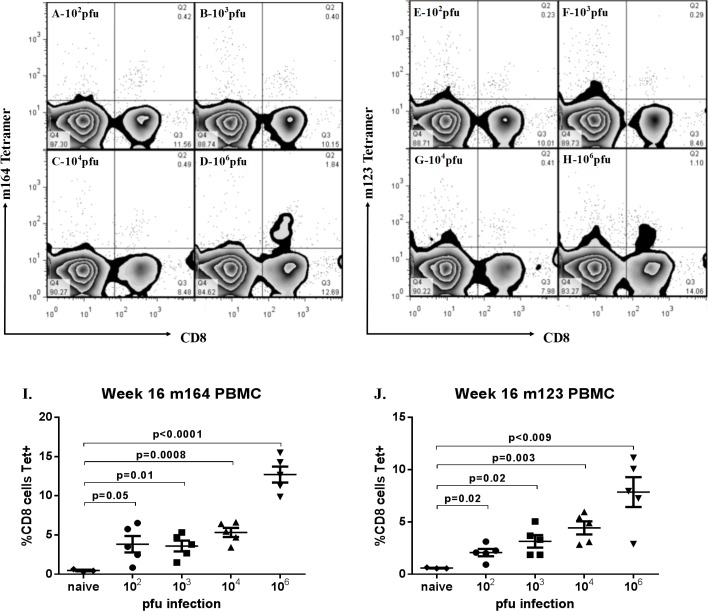
Murine Cytomegalovirus (mCMV) specific T-cell inflation depends upon infecting dose.Mice 8–10 weeks old infected intraperitoneally with 102 (A&E), 103 (B&F), 104 (C&G), or 106 (D&H) plaque forming units (pfu) Smith strain mCMV had peripheral blood mononuclear cells (PBMC) evaluated 16 weeks after infection for inflationary mCMV-specific T-cells. PBMC incubated with tetramers specific for m164 (A-D) or m123 (E-H) epitopes and CD8 were evaluated by flow cytometry and representative scatter plots from individual mice are shown. Mice infected with 106 pfu mCMV show classic inflation of m164 and m123-specific CD8+ cells as previously described by others (D&H). In contrast, mice infected with lower titers show less inflation by 16 weeks (m164 A-C, pp89 E-G). I&J. Summary of m164 and m123-specific T-cell results for each cohort 16 weeks after infection. Results represent a single longitudinal experiment. For I-J each point represents a single mouse, and bars represent mean and standard error for each cohort with corresponding p-values in comparison to naive.